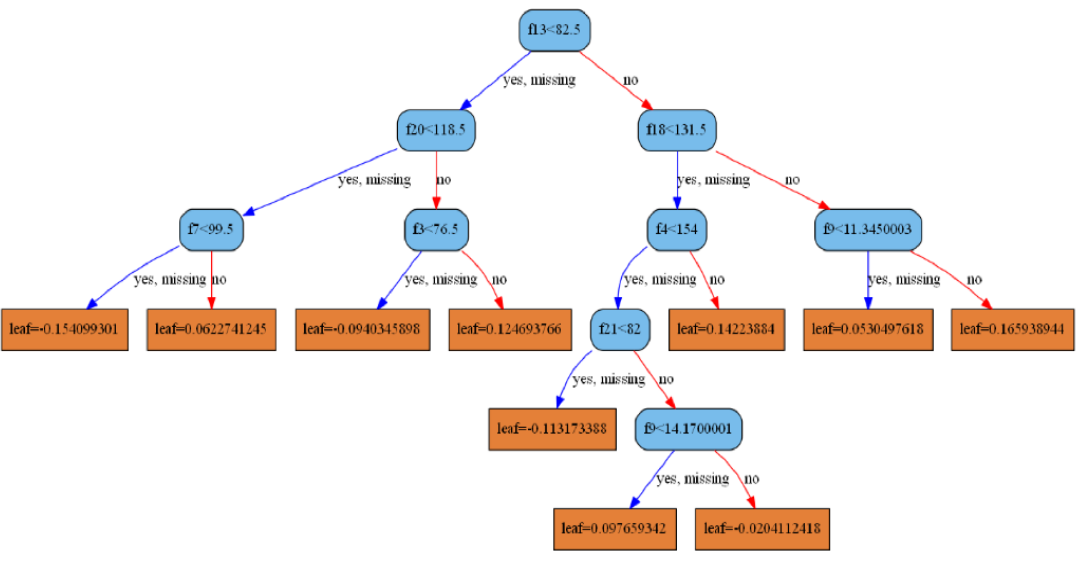
Figure 5. XGboost node graph. Table 7. Clustering and XGBoost methods for predicting symptom probability summary table.